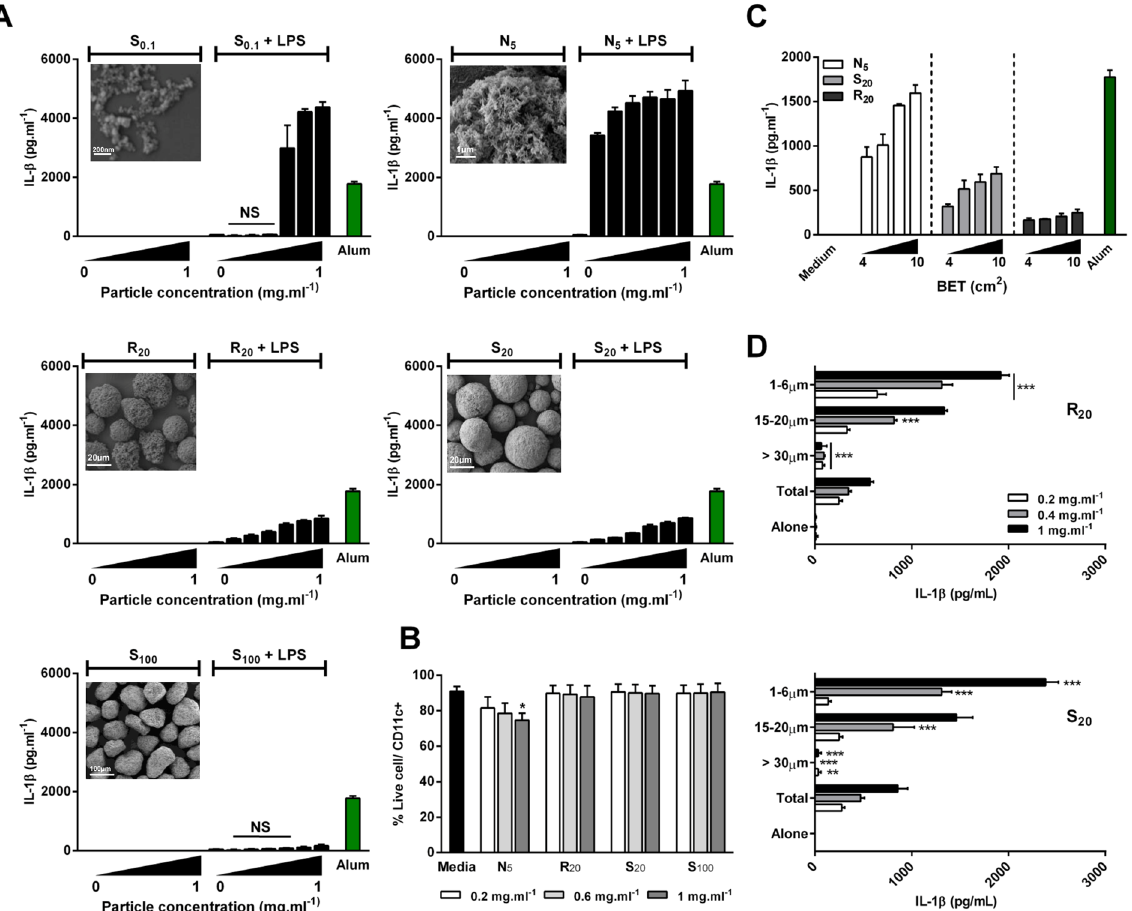
Figure 2. Hydroxyapatite particle size and shape dictates cytokine production by murine BMDCs. BMDCs (0.625 × 10 6 cells · ml − 1 ) from C57BL/6 mice were stimulated with concentrations ranging from 0.1 mg · ml − 1 to 1 mg · ml − 1 alone or after priming with LPS (1 ng · ml − 1 ) for 3 h. Supernatants were collected 24 hours later and tested for IL-1 β ( A , C , D ) by ELISA. Unprimed cells were collected and stained with LIVE/DEAD ® fixable Aqua dead cell stain and CD11c + and cell death was assessed by flow cytometry ( B ). Representative SEM pictures of HA particles ( A ). Results are mean cytokine concentrations ( ± SD) for triplicate samples (( A ) vs LPS alone; ( D ) vs Total, NS p > 0.05, * p < 0.05 and *** p < 0.001). Data are representative of three independent experiments. ( B ) Results are pooled from three independent experiments. Error bars show means ± SEM for triplicate samples (vs media * p < 0.05); NS: